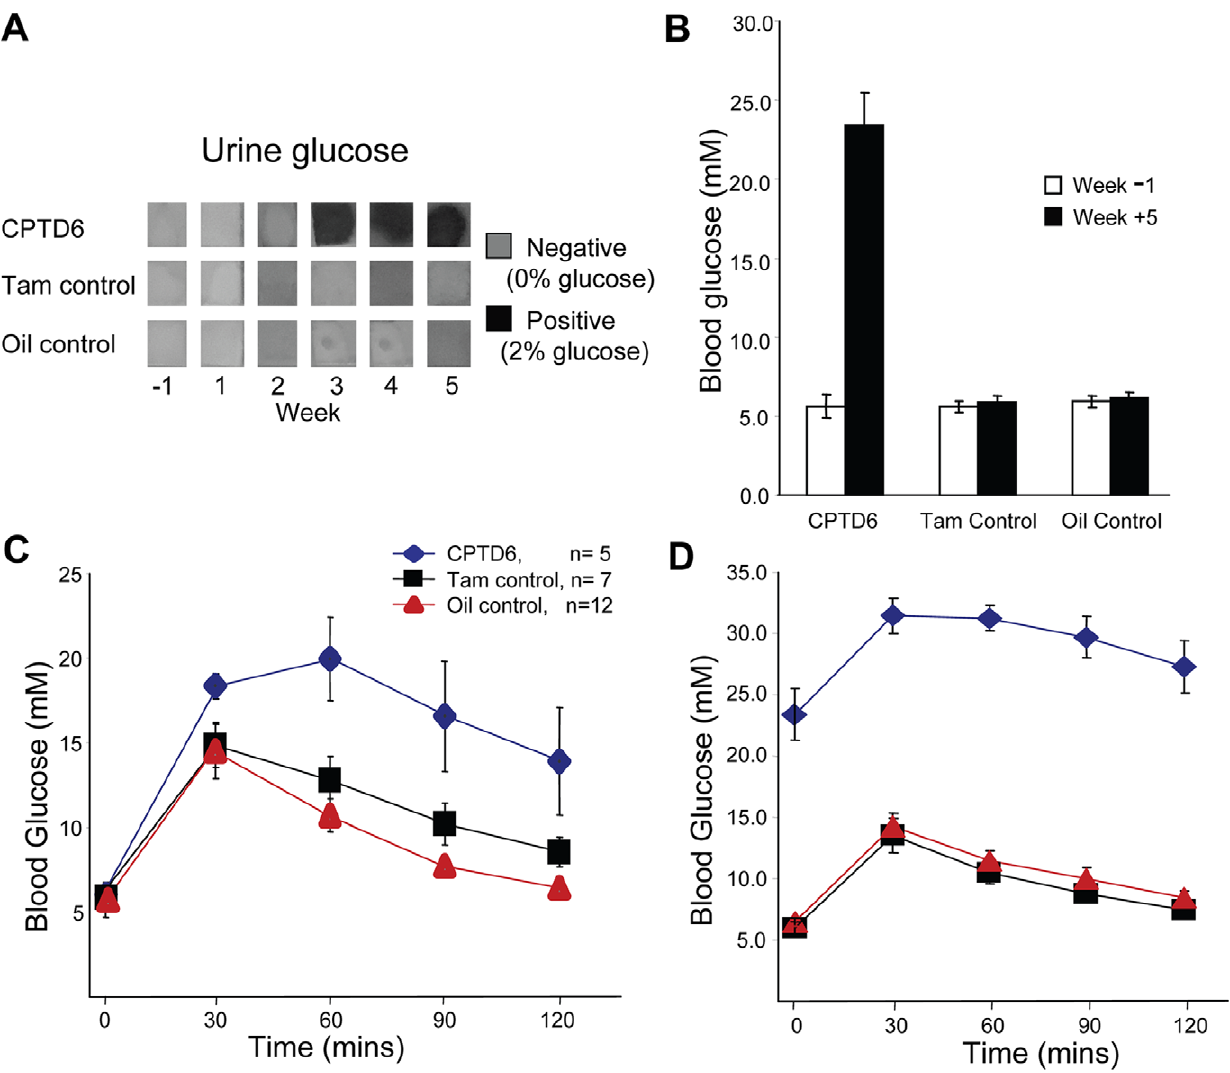
Figure 2. Assessment of glucose handling in control and CPTD6 mice. ( A ) Urine glucose levels were tested weekly using Diastix (Bayer) test sticks from week 0 (before first injection) to termination of the experiment (week 5). CPTD6 mice presented with glucose in their urine when tested 3 weeks post first injection. None of the control animals (tamoxifen- nor oil-injected controls) showed glucose in their urine at any time. ( B ) Fasting blood glucose levels were normal in all three experimental groups in the week prior to the tamoxifen/oil injections (white bars). When tested again in the final week of the experiment (start of week 5) CPTD6 mice presented with hyperglycaemia (black bars) ( C ). A glucose tolerance test performed in the week before injection revealed slight glucose intolerance in CPTD6 mice compared to the control animals. ( D ) Glucose intolerance of the CPTD6 mice was exacerbated post injection. Data are shown as mean 6 SEM.